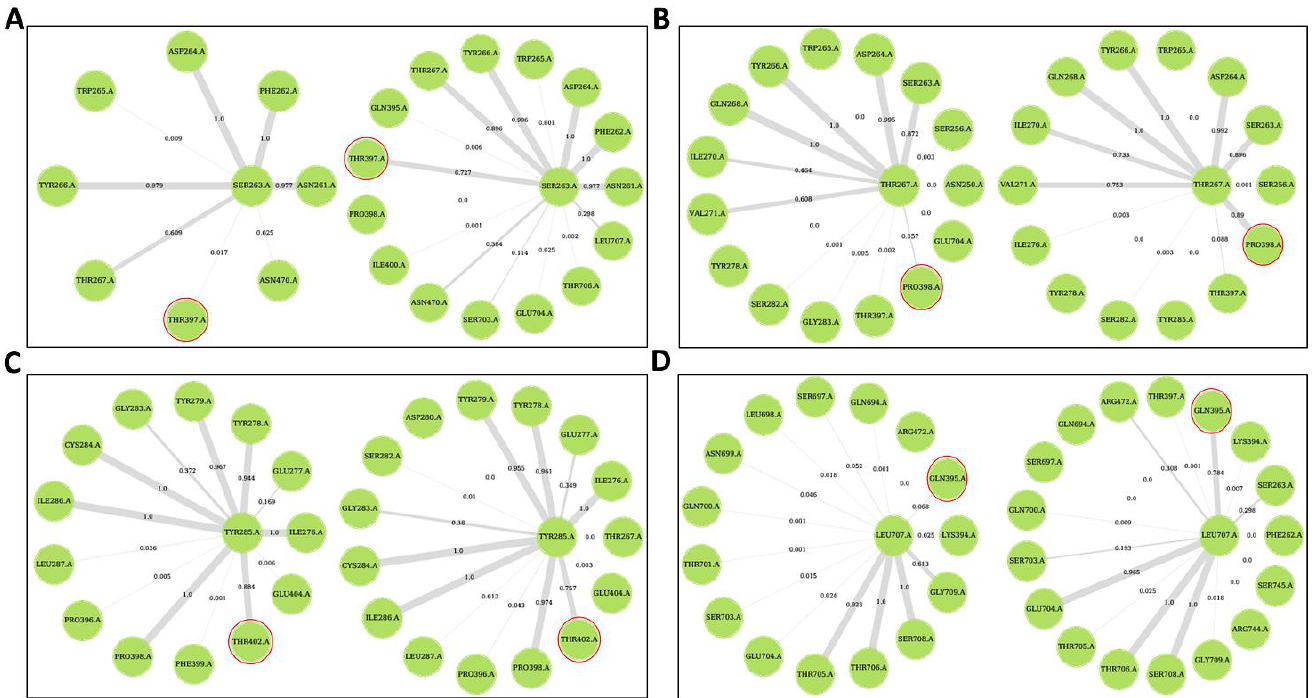
Figure 12. Frequency of contacts at the determined allosteric site in the holo (left sub-figure) and the ligand-bound complexes (right sub-figure). The allosteric site residue is shown in the middle of each contact map while residues at the ATP binding TXE loop are circled in red. ( A ) Contact frequency between residue Ser263 and Thr397 ( B ) Contact frequency between residue Thr267 and Pro398, ( C ) Contact frequency between residue Tyr285 and Thr402 and ( D ) Contact frequency between residue Leu707 and Gln395.